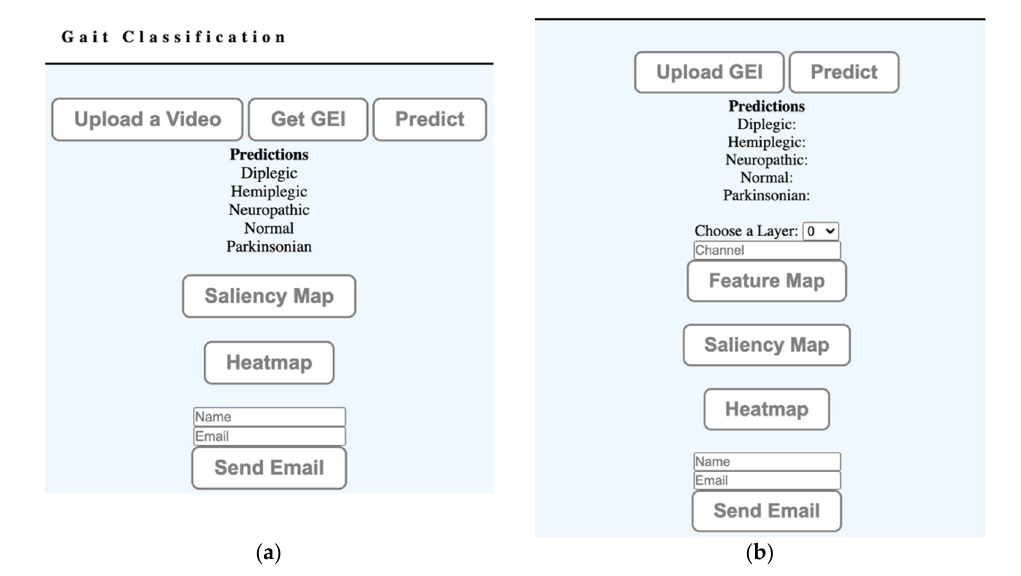
Figure 5. Web service user interface modes of operation: ( a ) basic, ( b ) advanced.